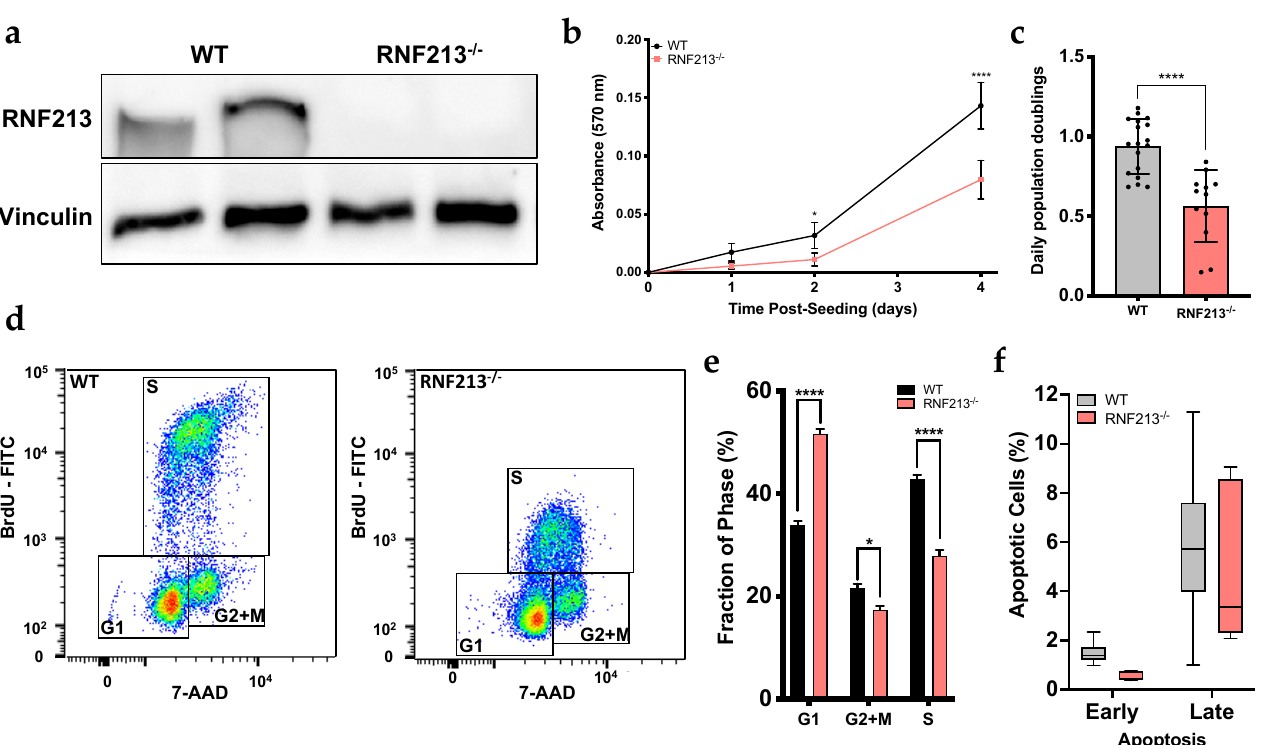
Figure 1. RNF213 invalidation and its effect on cell proliferation and cell-cycle regulation. ( a ) Western blot analysis showing the expression level of RNF213. Vinculin was used as a loading control. Total protein was extracted from confluent cells; ( b ) MTT assay over time to evaluate cell proliferation. n = 9–12; ( c ) Measurement of proliferation rate by calculating the daily doubling population. n = 12; ( d ) Cell-cycle analysis of proliferative hCMEC/D3 by flow cytometry using the BrdU FITC assay and 7-AAD labelling. n = 9; ( e ) Quantification of the proportion of cells in G1, G2+Mitose and S phases from the cell-cycle analysis; ( f ) Early and late apoptosis of hCMEC/D3 measured by flux cytometry analysis. Data from proliferative cells are shown. n = 6–9. * p < 0.05, **** p <